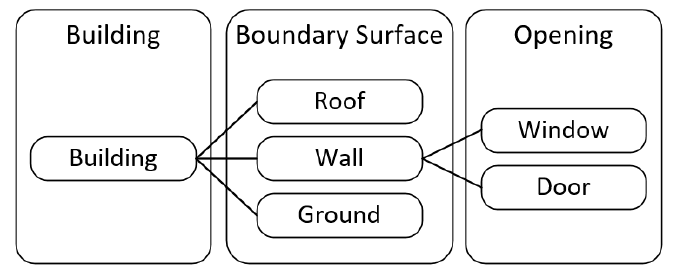
Figure 12. Relevant parts of the CityGML data model for LoD3 modelling.